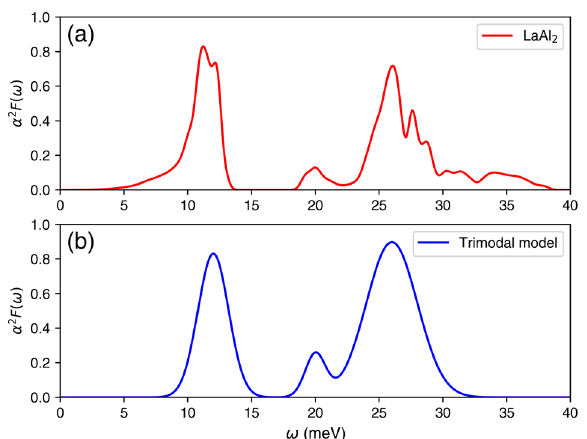
Fig. 2 Arti fi cial Gaussian α 2 F ( ω ) spectral functions. Comparison of a α 2 F ( ω ) for LaAl 2 with b a trimodal model α 2 F ( ω ) illustrates that the model spectral functions can resemble real materials.